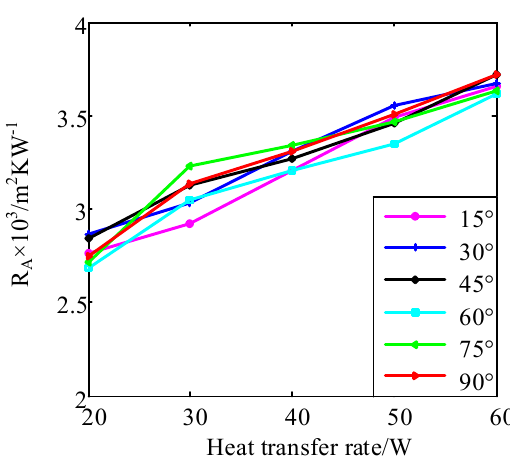
Figure 7. Relationship between the areal thermal resistance and heat transfer rate of the thermosyphon.